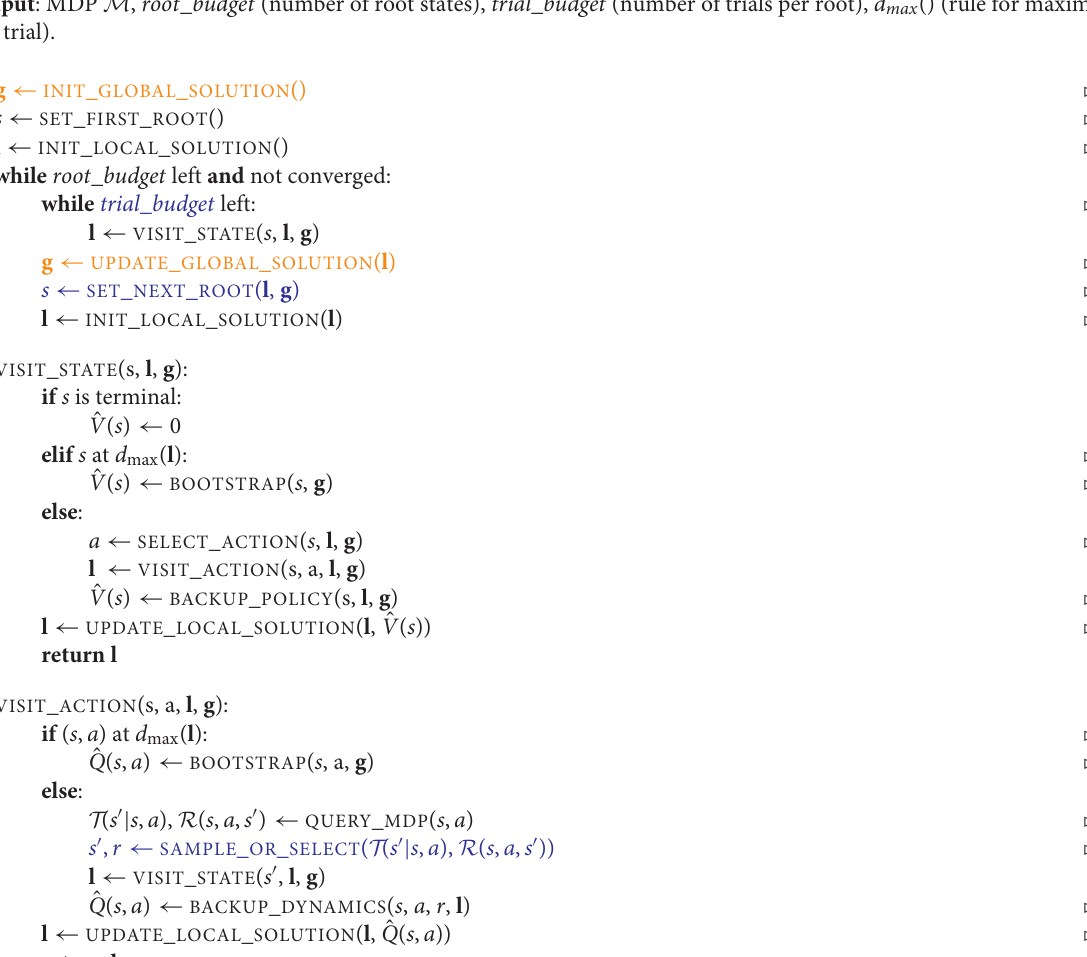
Algorithm 1: FRAP pseudocode. In planning, there is no global solution, and the orange lines therefore disappear (and g therefore drops from all functions as well). In model-free RL there are restrictions on the blue lines: we can only select actions and next states in a single forward trace per root, which indirectly restricts the trial budget per root (to the number of target depths we reweight over within the trace, which is often set to one) and the way we set the next root (which either has to be a next state we reached within the trial or a reset to an initial state of the MDP). In model-based RL, all elements of the framework can be active. Input : MDP M , root _ budget (number of root states), trial _ budget (number of trials per root), d max () (rule for maximum